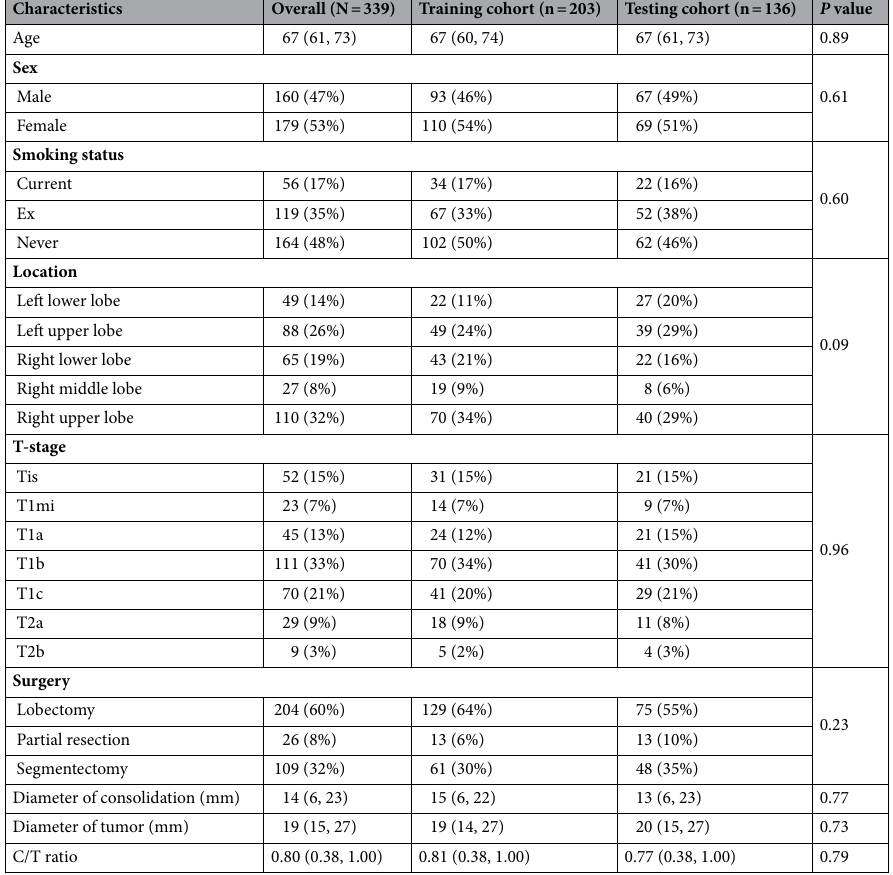
radiomics model. The regularization parameters for LASSO were tuned using fivefold cross-validation on the training dataset. The regularization parameters of the model with the highest AUC in the fivefold cross valida- tion were used to create the final model.